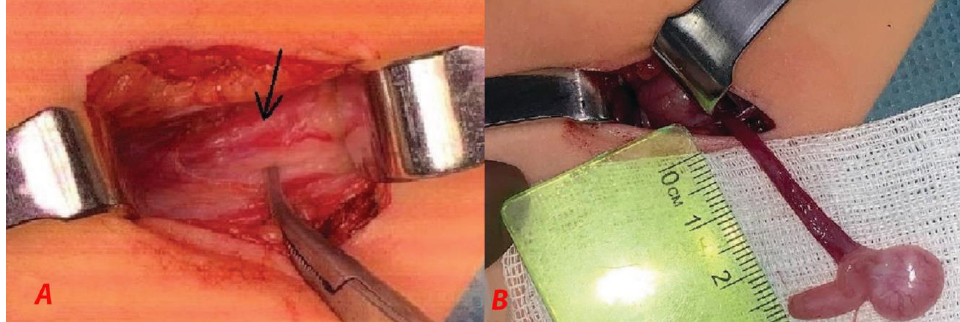
Figure 3. ( A ) The inguinal canal was opened. The arrow indicates the blind-ending deferent duct. ( B ) Testis with epididymis attached to testicular